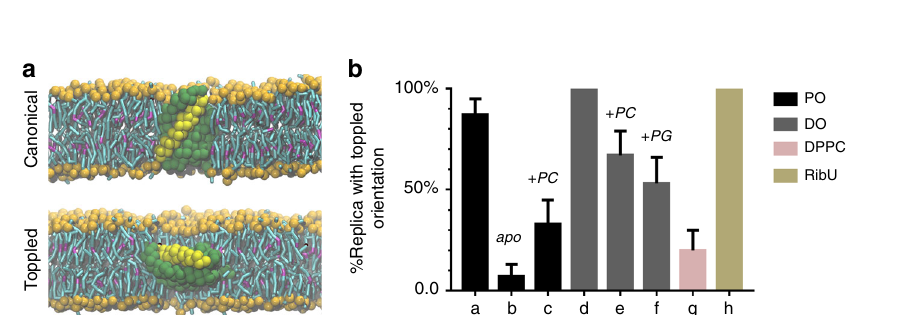
Fig. 2 Orientation of the S-component. a Snapshots of the S-component in canonical and toppled orientations. The S-component is shown in green and helix 5 in yellow. Both are plotted in van der Waals CG surface representation. The phosphate groups and tails of the lipids are shown in orange and cyan, respectively, with magenta for unsaturated parts of the tails. b Bar graph of orientational preference of the S-component starting from toppled state in different lipid environments in either apo or holo form (a: POPE-POPG-CL- holo S-component (ratio: 70:25:5), b: POPE-POPG-CL- apo S-component (ratio: 70:25:5), c: POPE-POPG-POPC- holo S-component (ratio: 60:20:20), d: DOPE-DOPG-DOPC- holo S-component (ratio: 60:20:20), e: DOPE-DOPG-DOPC- holo S-component (ratio: 50:13:37), f: DOPE-DOPG-DOPC- holo S-component (ratio: 30:30:40), g: DPPC- holo S-component, h: POPE-POPG-CL- holo RibU S-component (ratio: 70:25:5)). The error bars represent standard deviation. The lipid abbreviations are according to Table 1. Source data are provided as a Source Data fi